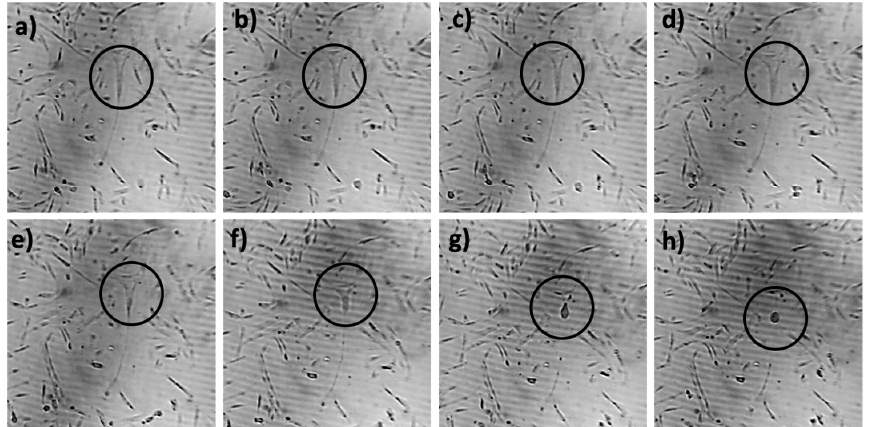
Figure 10. Sequential images of the time-lapse video ( a – h ). The possible formation of an unstable transient myotube is circled in black.